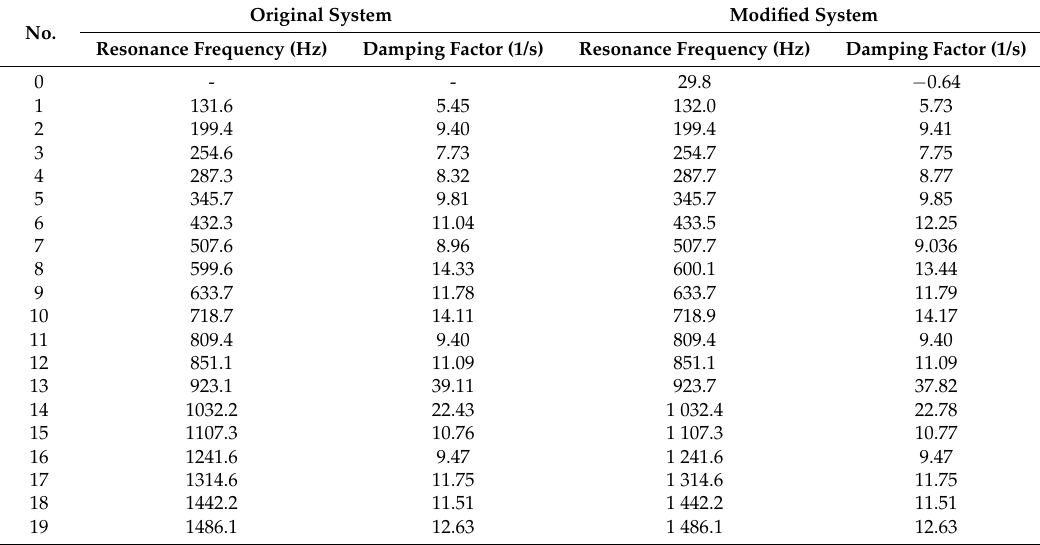
Table 1. Electric network resonance stability ( ENRS) analysis results for the original and modified 39-bus systems.